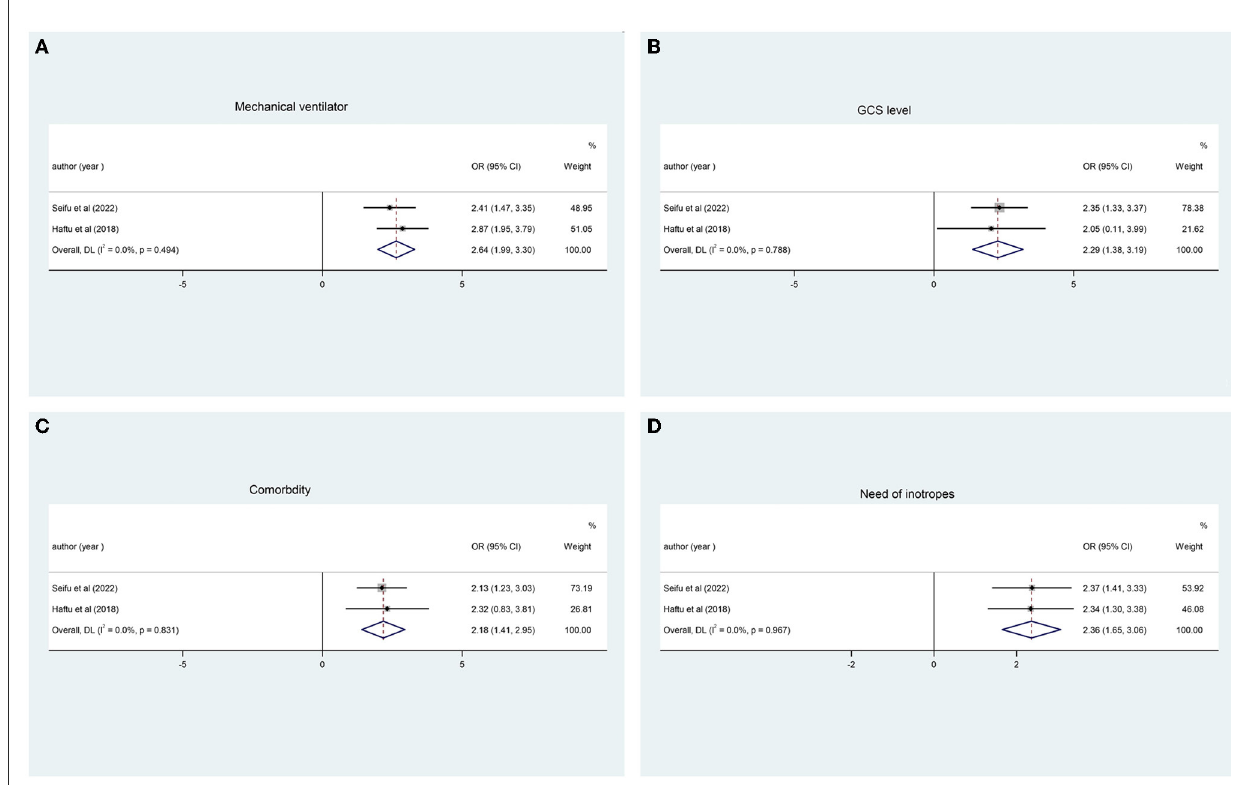
FIGURE6 Determinant factors for pediatric mortality. (A) Use of a mechanical ventilator. (B) Level of GCS < 8. (C) Presence of comorbidity. (D) Use of